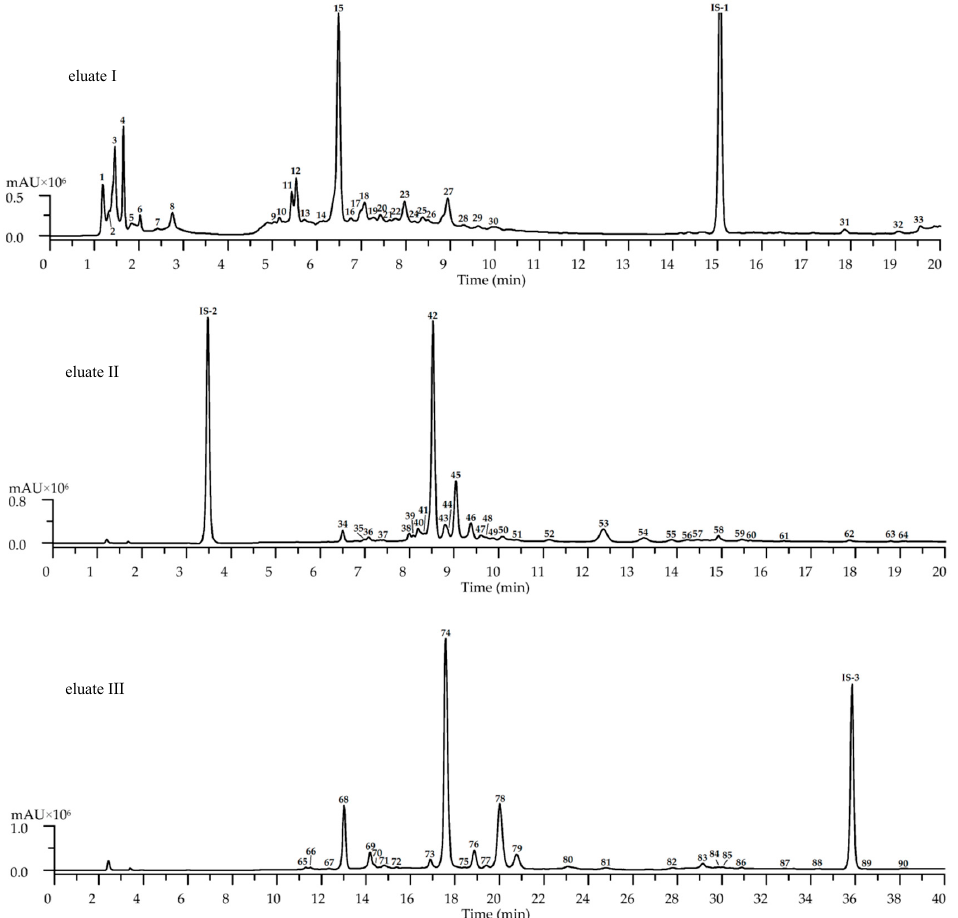
Figure 1. High-performance liquid chromatography with electrospray ionization triple quadrupole mass spectrometric detection (HPLC-ESI-tQ-MS) chromatogram (base peak chromatogram or BPC mode) of solid-phase extraction (SPE)-polyamide eluate I (chromatographic conditions—mode 1, positive ionization), eluate II (chromatographic conditions—mode 2, negative ionization), and eluate III (chromatographic conditions—mode 3, negative ionization) of Galeopsis bifida herb extract. Compounds are numbered as listed in Table 2. Internal standards: IS-1—trifloroside (38 µ g / mL); IS-2—scopoletin-7- O -neohesperidoside (48 µ g / mL); IS-3—3,5-di- O -feruloylquinic acid (9.5 µ g /